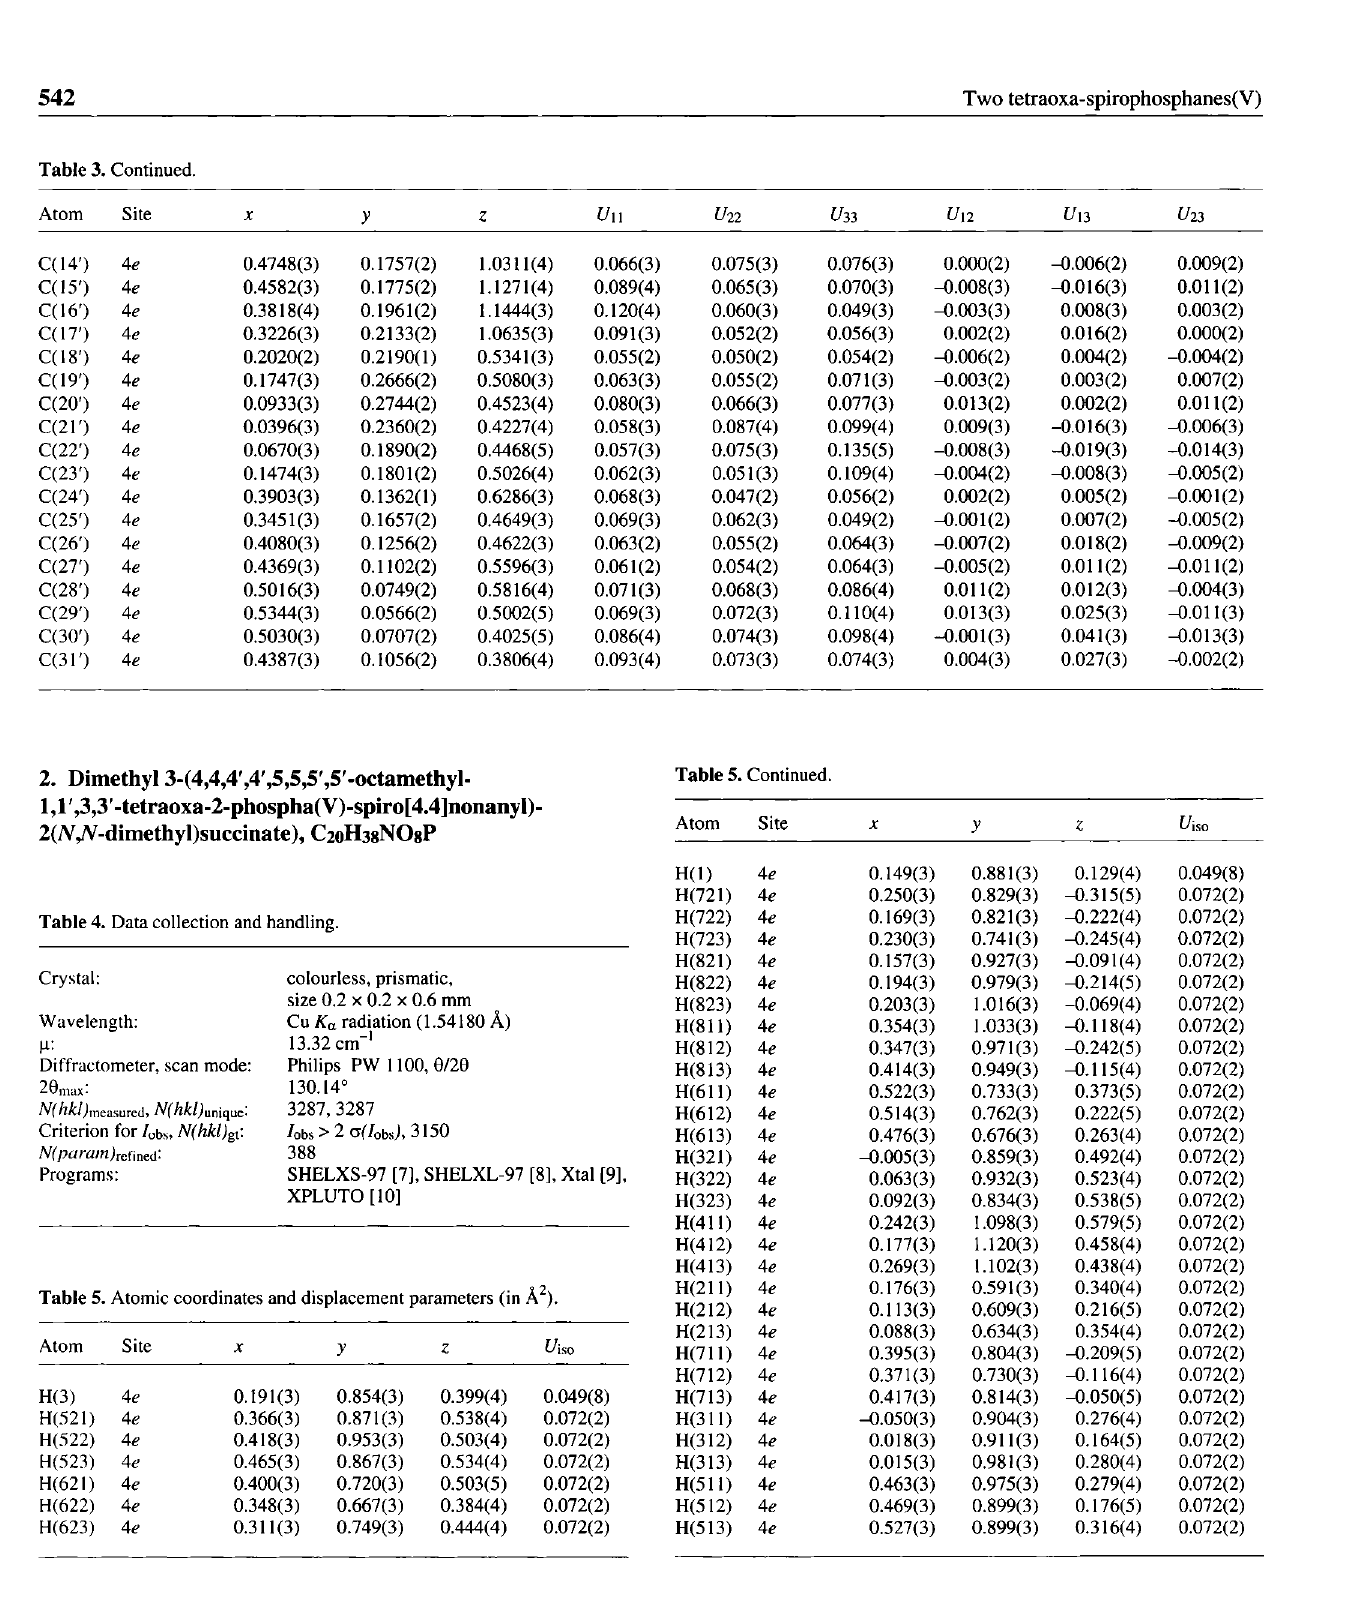
Table 5. Atomic coordinates and displacement parameters (in Â 2 ).